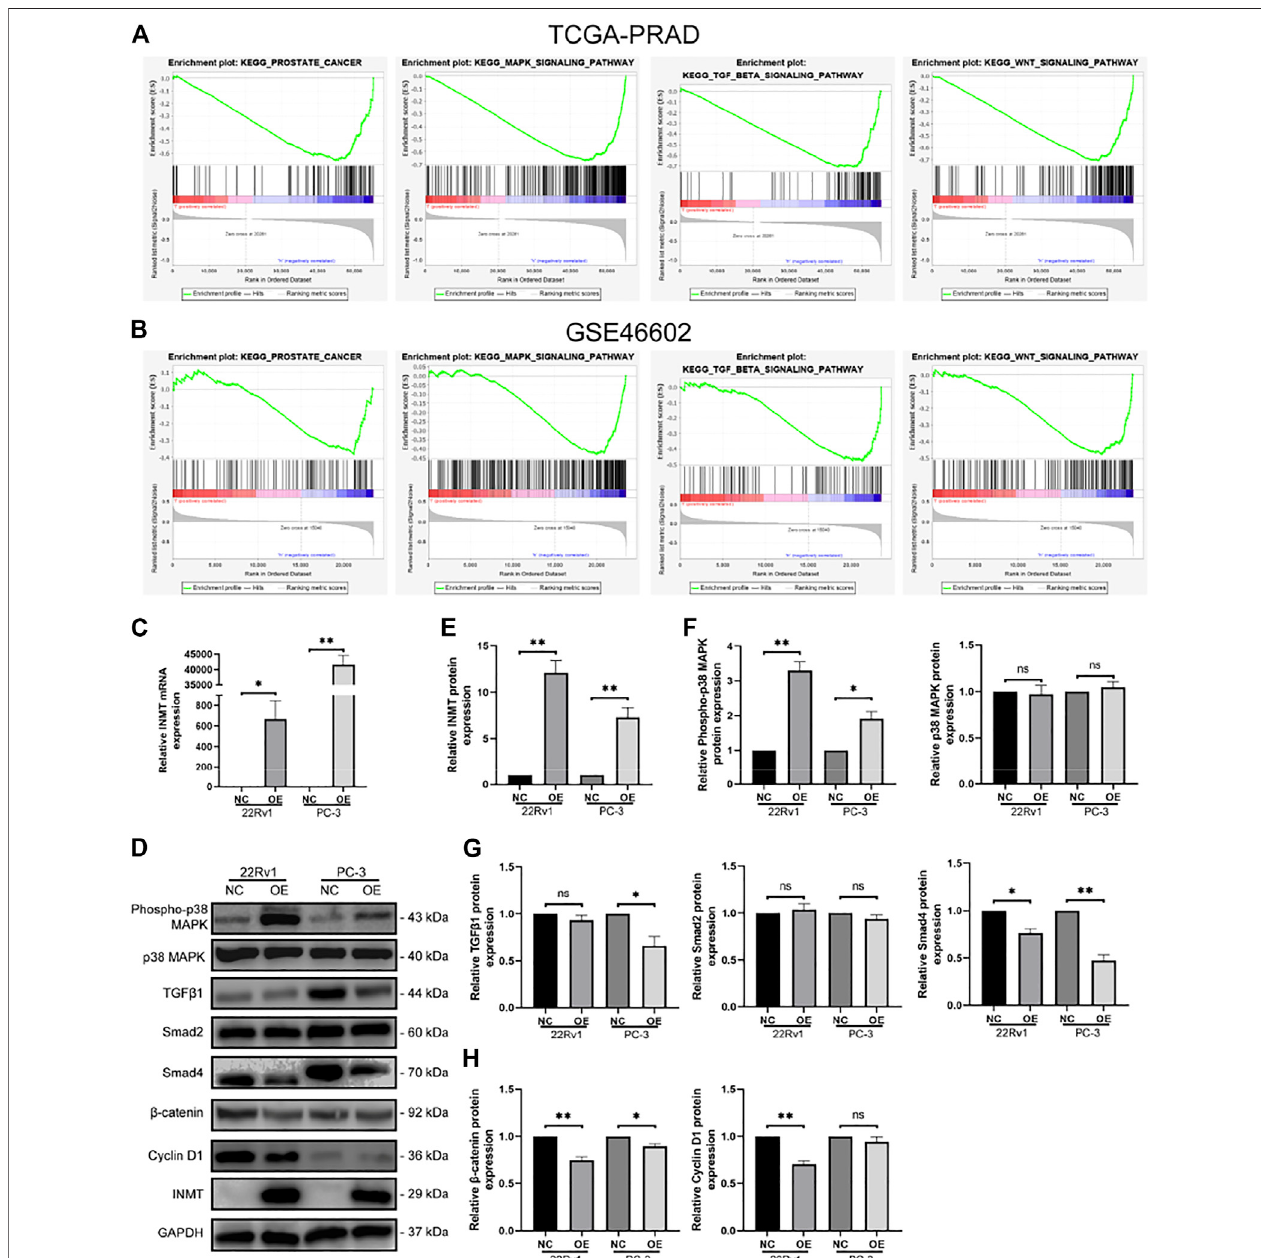
FIGURE 2 | Correlation between INMT and tumor signaling pathways. (A,B) In TCGA and GSE46602, INMT was enriched in prostate cancer, MAPK signaling, TGF β signaling, and Wnt signaling pathways. After transfection with corresponding negative control lentiviral vector and INMT overexpression lentiviral vector in 22Rv1 and PC-3, (C) mRNA levels of INMT were measured using real-time PCR, and (D,E) protein levels of INMT were measured using western blot. (D,F) Protein levels of MAPK signaling pathway-related molecules (Phospho-p38 MAPK, p38 MAPK) were measured using western blotting. (D,G) Protein levels of TGF β signaling pathway-related molecules (TGF β 1, Smad2, and Smad4) were measured using western blot. (D and H) The protein levels of Wnt/ β -catenin signaling pathway-related molecules ( β - catenin and cyclin D1) were measured using western blot. The samples derive from the same experiment, and those blots were processed in parallel.